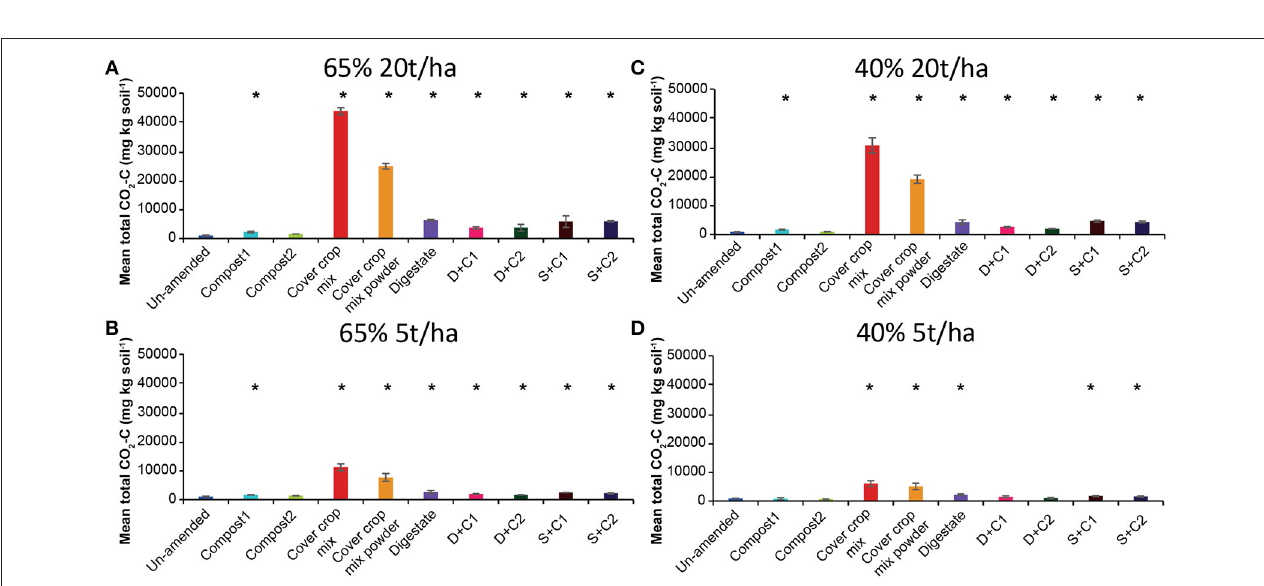
FIGURE 2 | Mean total CO 2 emitted over the period of 28 d in un-amended clay soil and after amendments with compost1, compost2, CC residues mixtures, digestate, digestate + compost1, digestate + compost2, sewage sludge + compost1, and sewage sludge + compost2 (mean ± SD; n = 3) at (A) high amount (20 t/ha) and high water content (65%), (B) low amount (5 t/ha) and high water content, (C) high amount and low water content (40%), and (D) low amount and low water content, derived from the cumulative CO 2 ( Supplementary Figure 2 ) fluxes. Asterisk (*) indicate significant differences in the mean total CO 2 fluxes between the soils with organic amendments and the un-amended soil within the four separate superordinate treatments (ANOVA: P < 0.05).